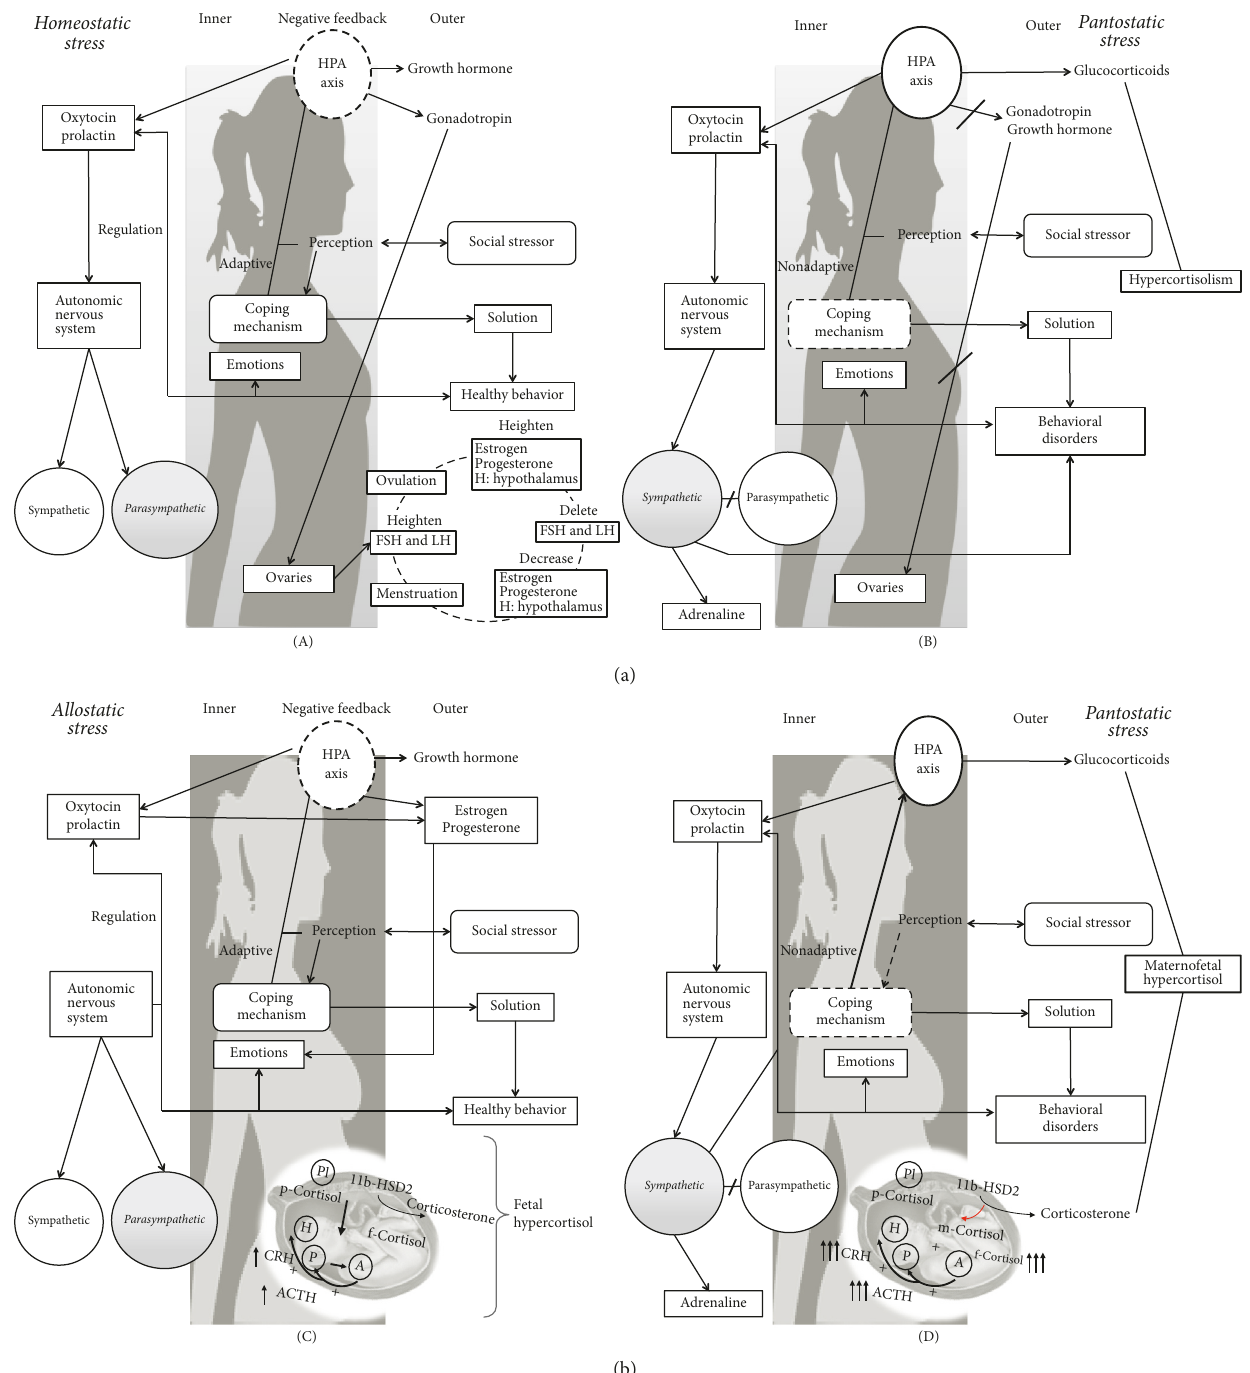
Figure 1: Biopsychosocial stress in nonpregnant and pregnant women. H: hypothalamus; P: pituitary; A: adrenal; PL: placenta; m, p, or f cortisol: maternal, placental, or fetal cortisol; p CRH: placental CRH; +: positive feedback loop; − : negative feedback